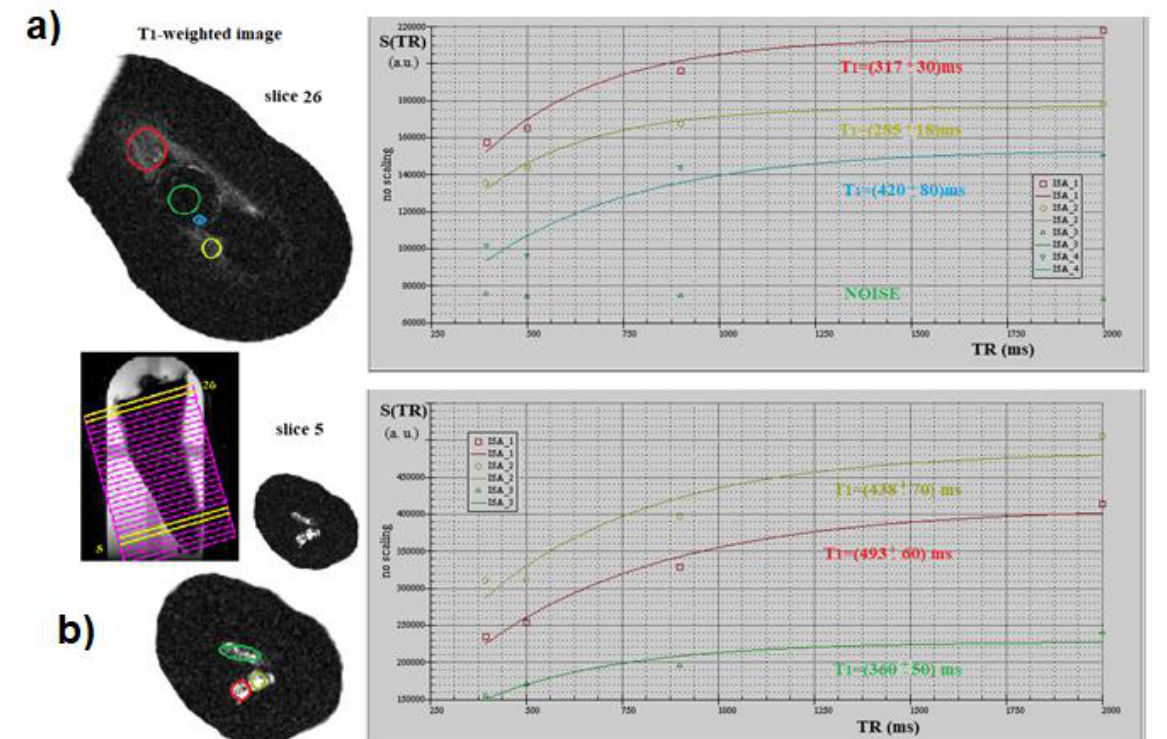
Figure 4. T1 quantification in different tooth ROIs. The green ROI in the selected Gutta-percha area shows no signal, i.e., noise ( a ). Other selected zones of the tooth (red, yellow and blue ROIs) are characterized by different T1 values. Specifically, hyperintense voxels (bright white) highlighted in blue ROI of ( a ) and the three ROIs in ( b ), indicating incomplete filling, are characterized by a higher T1 value if compared to the tertiary dentin (red and yellow ROI) present in caption ( a ). In ( b ), the apical area of the tooth is not completely sealed, since there is an appreciable amount of water around the Gutta-percha cone: this could be explained by the fact that the cold condensation technique used was unable to guarantee a three-dimensional effective sealing.